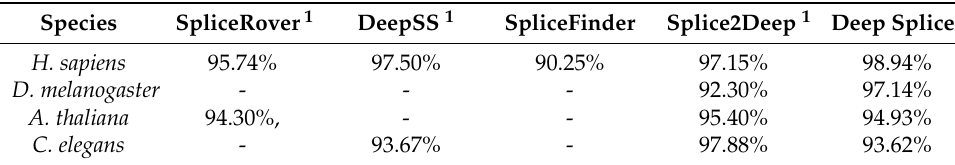
Table 7. Accuracy comparison of different splice predictor